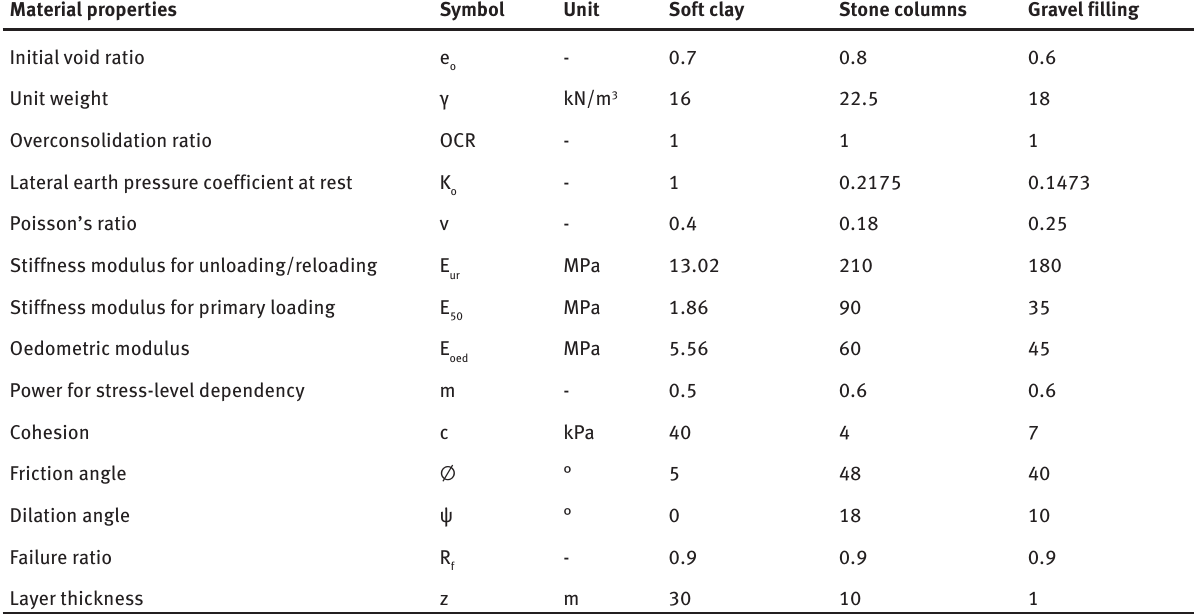
Table 1: Material properties used in the model. Material